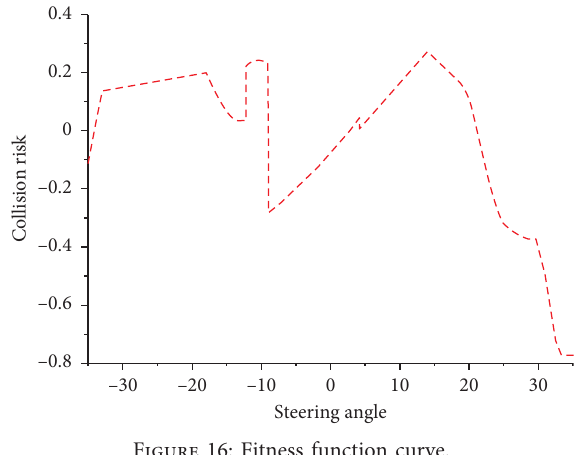
Figure 16: Fitness function